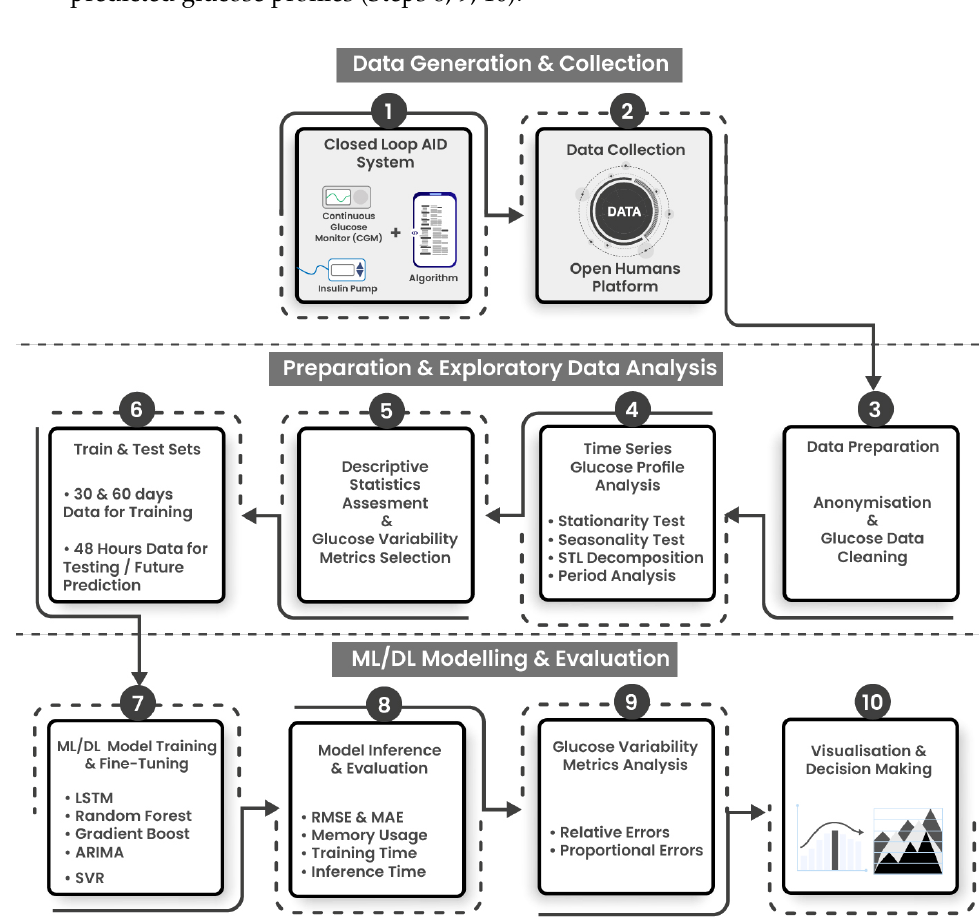
Figure 2. Tri-staged experimental workflow and ML/DL development pipelines for glucose data analysis. Stage 1 includes data generation and collection, stage 2 involves data preparation and exploratory statistical analysis, and stage 3 consists of ML/DL modeling, evaluation and